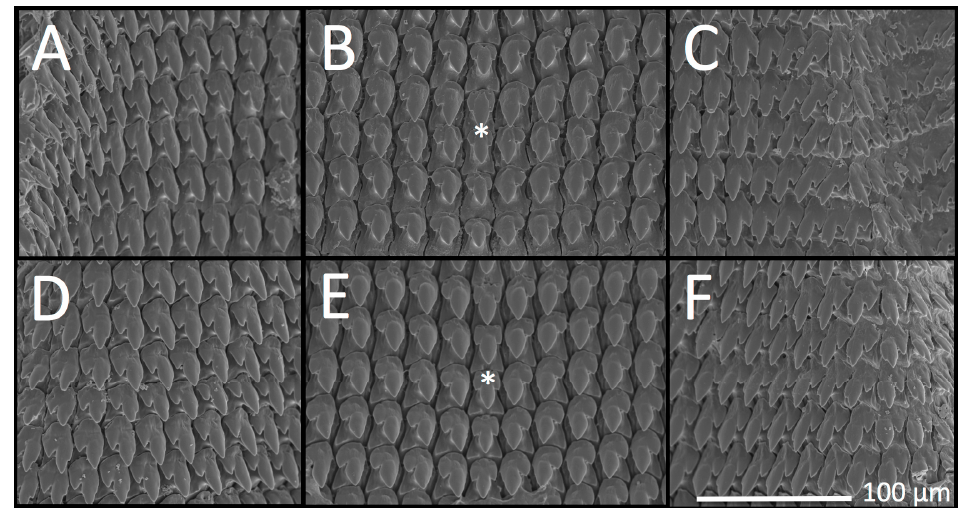
Figure 4. Theba pisana (Müller, 1774) radulae as SEM images from specimens collected in San Pedro, Los Angeles Co. ( A – C ) and San Elijo Lagoon Ecological Reserve, San Diego Co., California, USA ( D – F ). ( A – C ) from outside the Marine Mammal Care Center, LACM 182330; ( A , C ) lateral and marginal teeth; ( B ) central and lateral teeth; ( D – F ) from Santa Carina trail, LACM 182335; ( D , F ) lateral and marginal teeth; ( E ) central and lateral teeth. Asterisks indicate a central tooth within the central vertical tooth row.